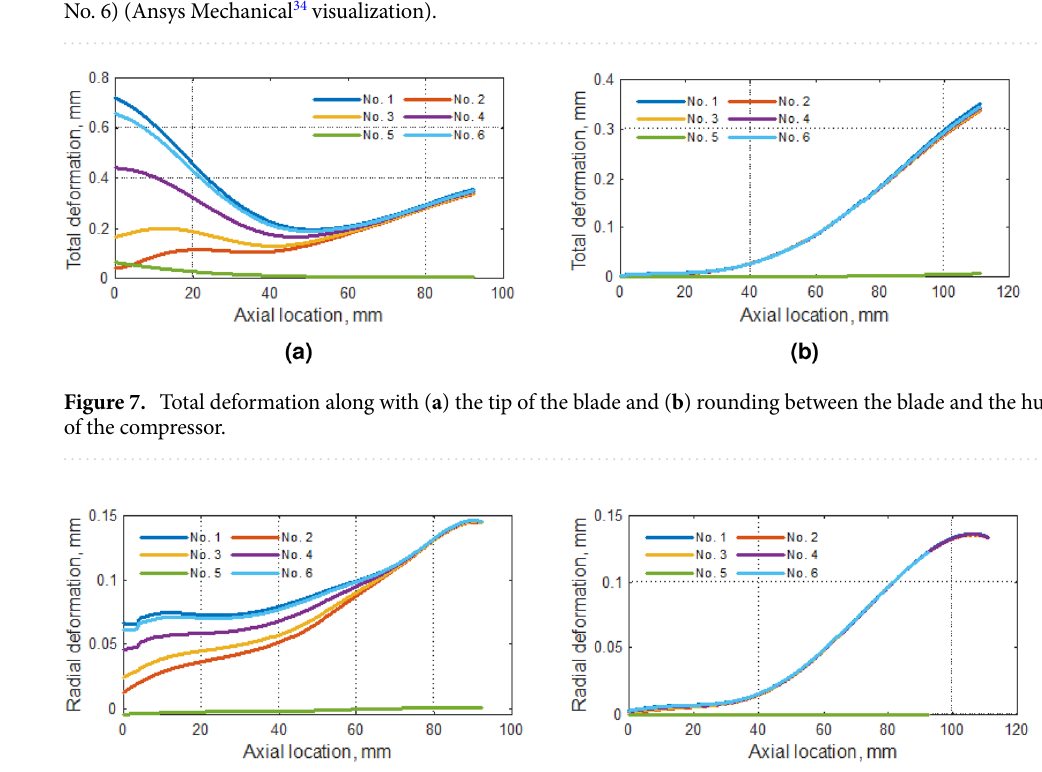
Figure 6. Distribution of ( a ) radial and ( b ) circumferential deformation of the centrifugal compressor (analysis No. 6) (Ansys Mechanical 34 visualization).